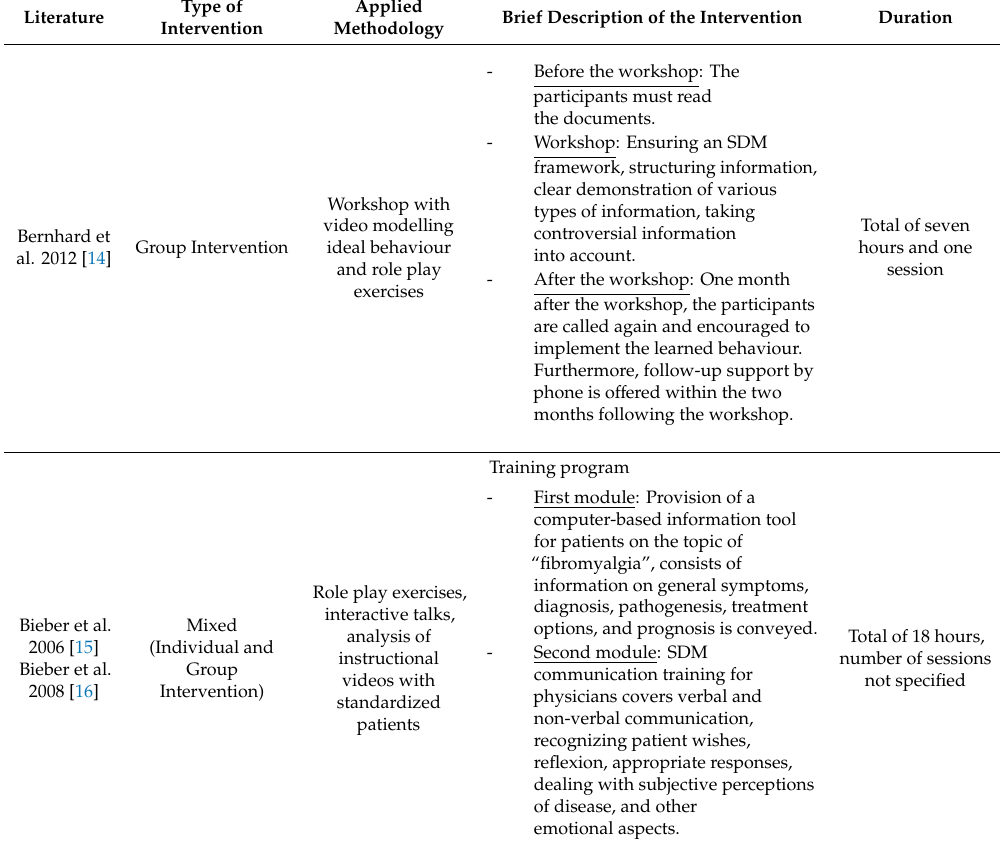
Table 3. Interventions—Studies on continuing medical